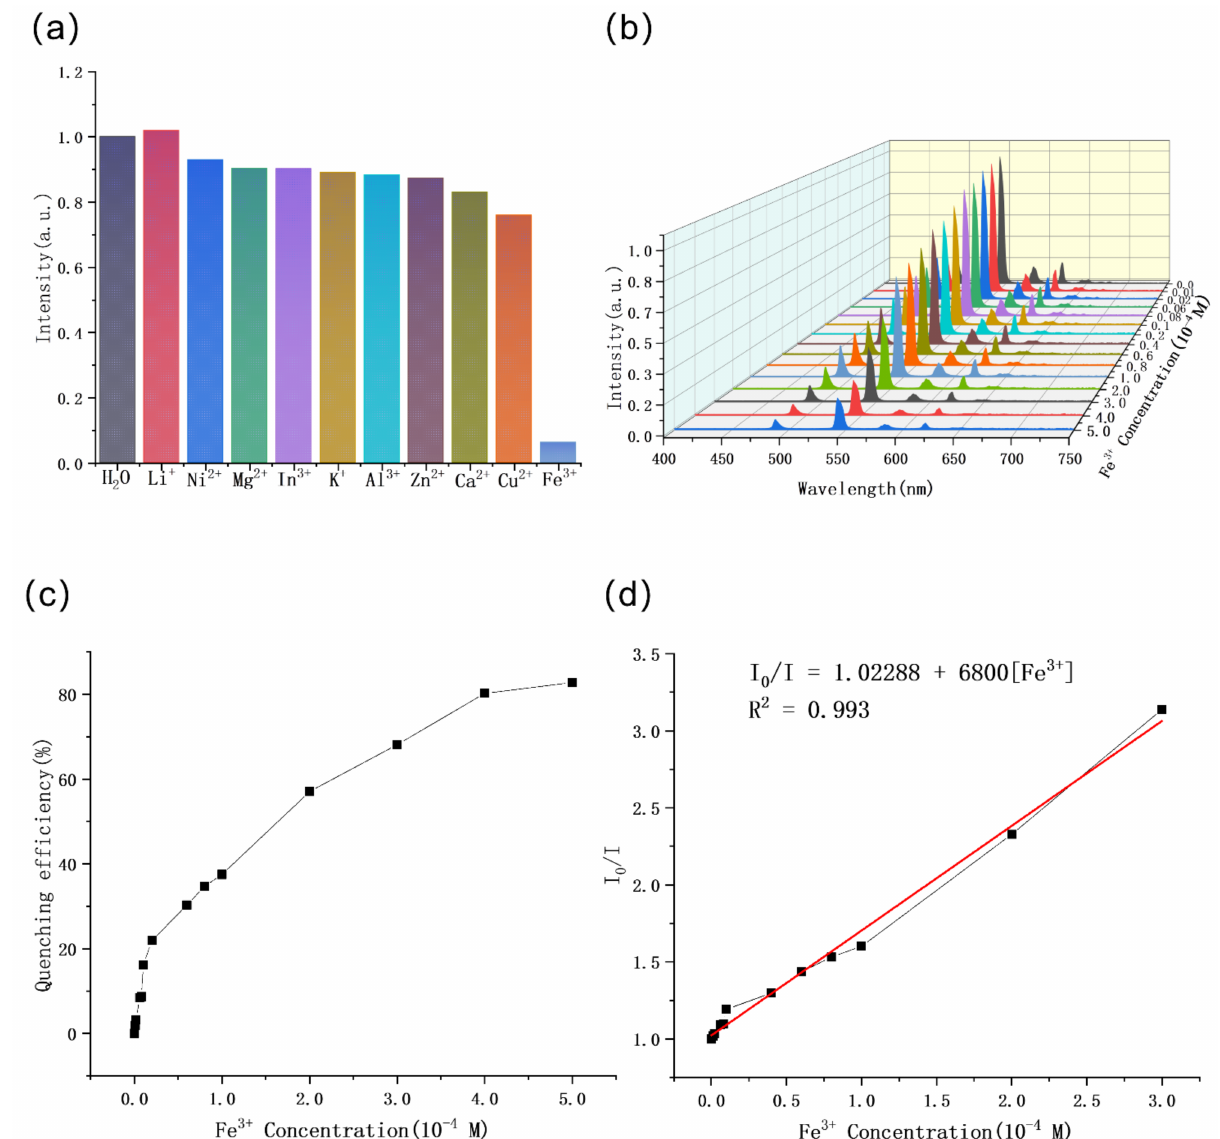
Figure 4. ( a ) Comparison of the 5 D 4 → 7 F 5 photoluminescence intensity of 2 in water and aqueous solutions containing different metal ions when excited at 299 nm. ( b ) Photoluminescence spectra, ( c ) quenching efficiency, and ( d ) a Stern-Volmer plot of 2 with a gradual increase of the Fe 3+ concentration in aqueous